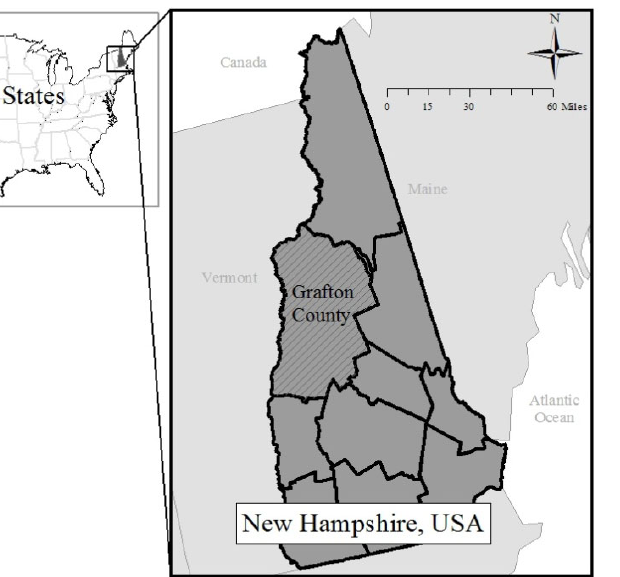
Figure 2. Grafton County, New